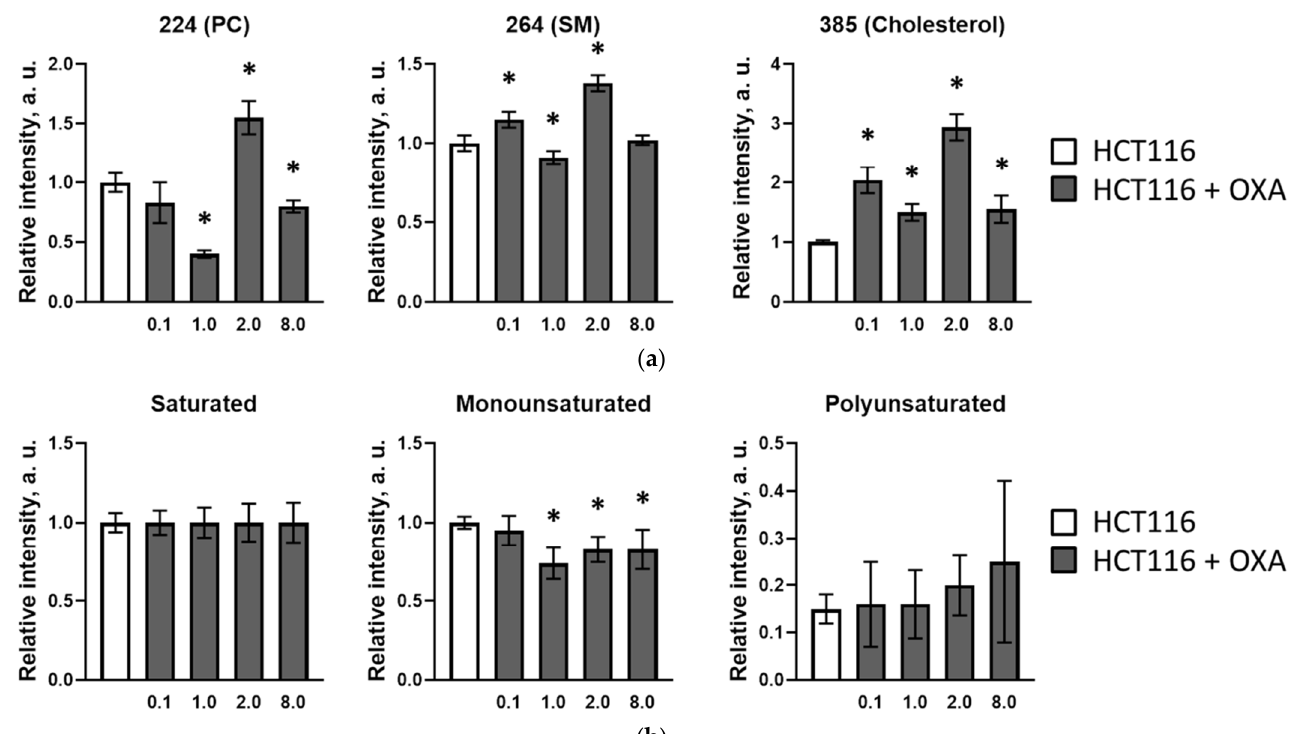
Figure 2. ToF-SIMS analysis of plasma membrane lipid composition of cultured HCT116 cells adapted to different oxaliplatin doses. ( a ) Phosphatidylcholine (PC) ( m/z 224), sphingomyelin (SM) ( m/z 264) and cholesterol ( m/z 385) ion yields obtained in positive ions. Data normalized to corresponding lipid intensities of a control sample. ( b ) Saturated, mono- and polyunsaturated fatty acids ratio in control cells and cells adapted to the indicated doses of oxaliplatin. Data normalized to the saturated fatty acids signal of corresponding sample. *, p ≤ 0.05 with control.